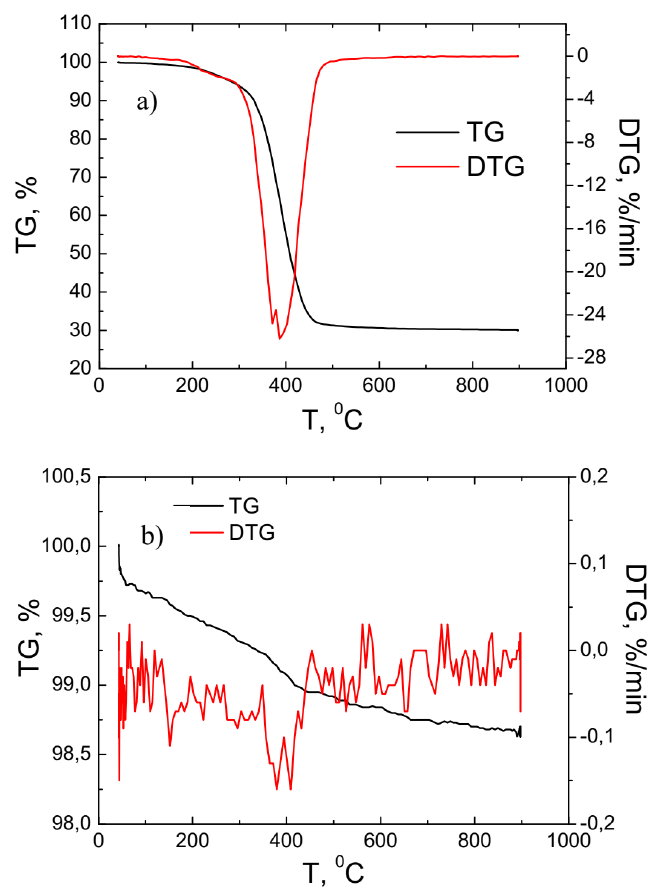
Figure 3. TG and DTG investigation results of the primary powder ( a ) and fiber ( b ).